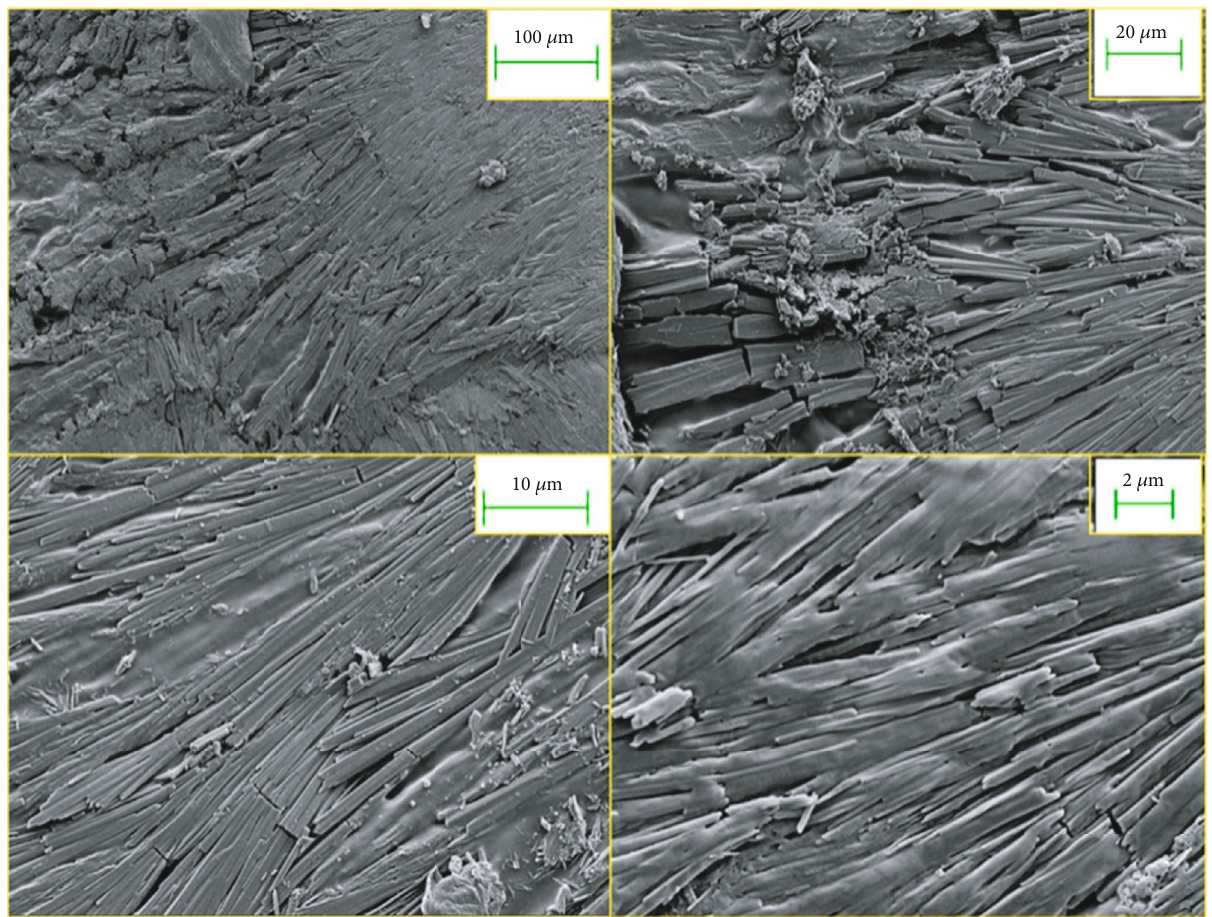
Figure 1: SEM of FA from brown seaweed (The FA (2-10 μ m) exhibits regular, layered, patched and smooth, and fl at continuous sheet